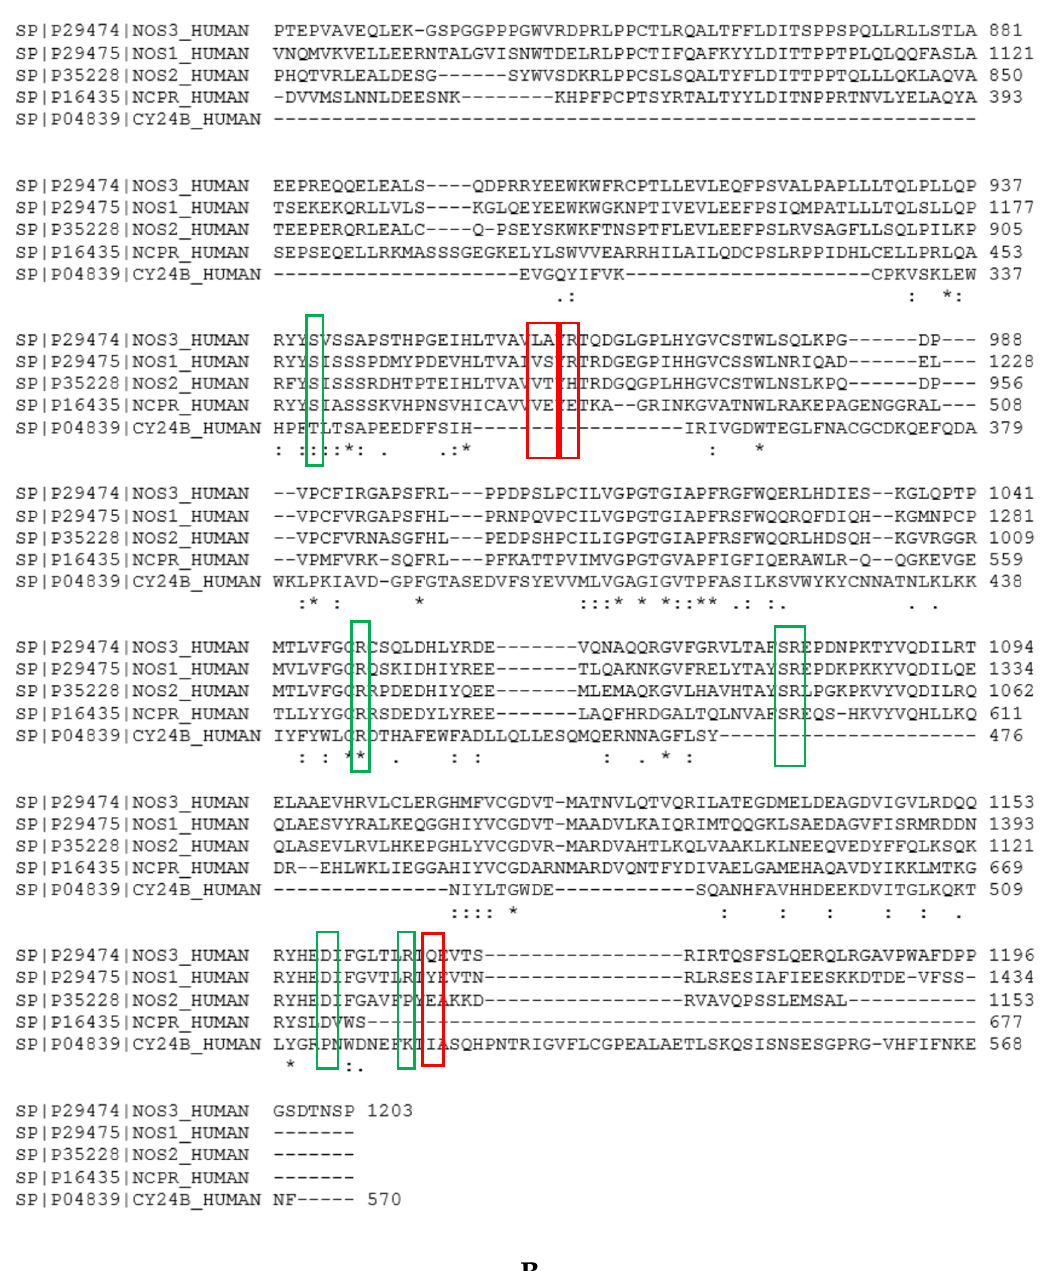
Figure A6. Targeting eNOS variable residues using multiple alignments. ( A ) The sequence alignment between the nNOS (NOS1) P29476 (750:1413) and eNOS (NOS3) P29474(515:1178) shows that 56.2% of residues are identical and 30.7% are similar, accounting for a 86.9% total homology. The color code is: deep blue: conserved residues, light blue or white: non conserved residues. The targeted residues, S1200, H1202, Y1426 for nNOS, and A961, R963 and Q1167 for eNOS, are highlighted in red. ( B ) Alignment of some human proteins containing NADPH sites: eNOS, nNOS, iNOS, P450 reductase and NOX2 (GP91phox). The conserved residues involved in the recognition of the charge (by 2’ phosphate of NADPH and of NT1, 2’carboxylate or 3’ carboxylate of NT3_7 or NT3_5) and of the catalytic S941 and D1158 are highlighted by a green box; R1049 is totally conserved among the five proteins, R776 (not shown), S941, D1158, S1078, and R1079 are conserved among the NOS and P450 reductase while R1165 is only shared by eNOS and nNOS. The targeted variable residues A961, R963 and Q1167 targeted by hook 2 are highlighted by a red box. We also found that L960, a variable residue unique to eNOS makes hydrophobic interactions with the chromophore of NT3_5h.